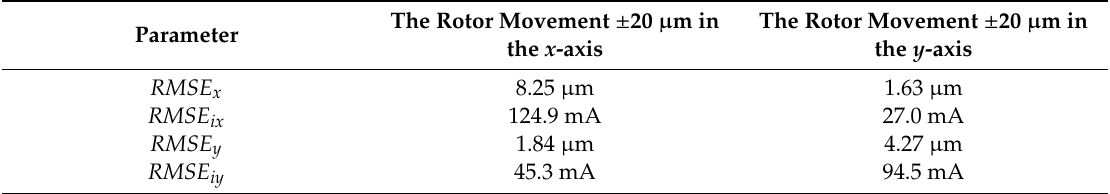
Table 5. Root mean squared errors (RMSEs) values for a 2 s transient.